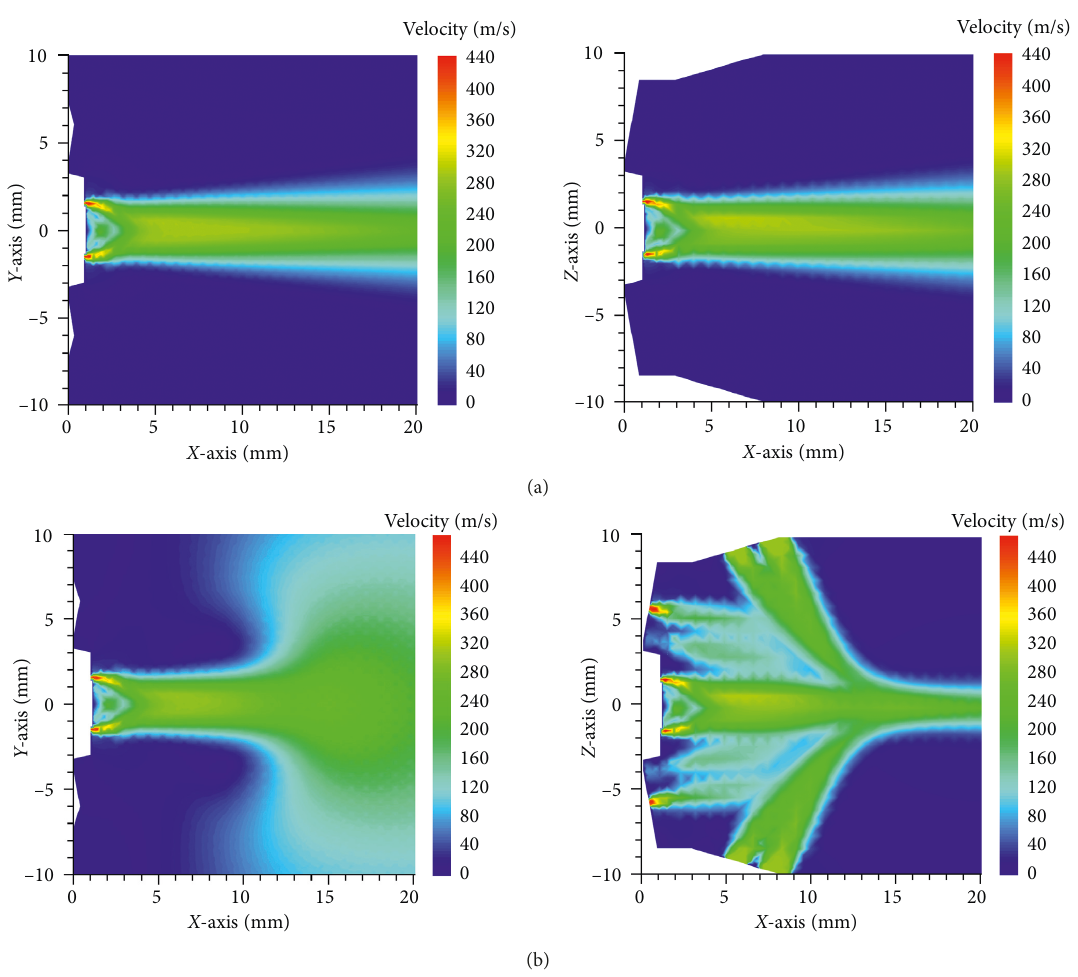
Figure 7: Comparison of calculated spatial distribution of velocity field. (a) Velocity contours for single-hole nozzle: X - Y plane (left); X - Z plane (right). (b) Velocity contours for multiorifice nozzle: X - Y plane (left); X - Z plane